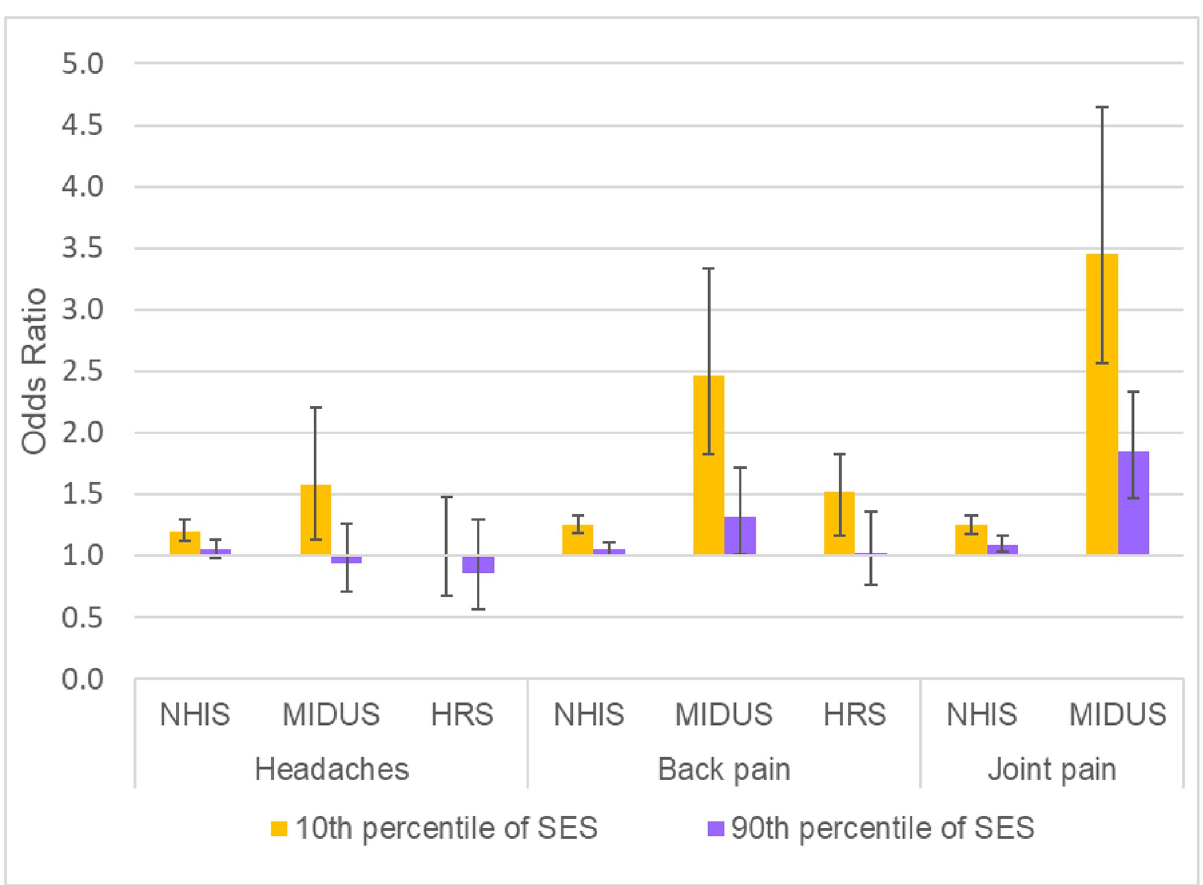
Fig 5. Period change in specific types of pain at age 50 for 10 th vs. 90 th percentile of SES. These results are based on the models shown in Tables G, I, and K in S1 Appendix.